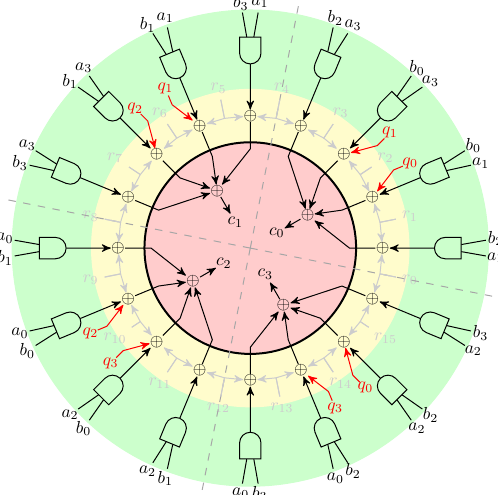
Figure 14: The robust-3-SNI CMS scheme proposed in this paper. Additional random are identified with the label q